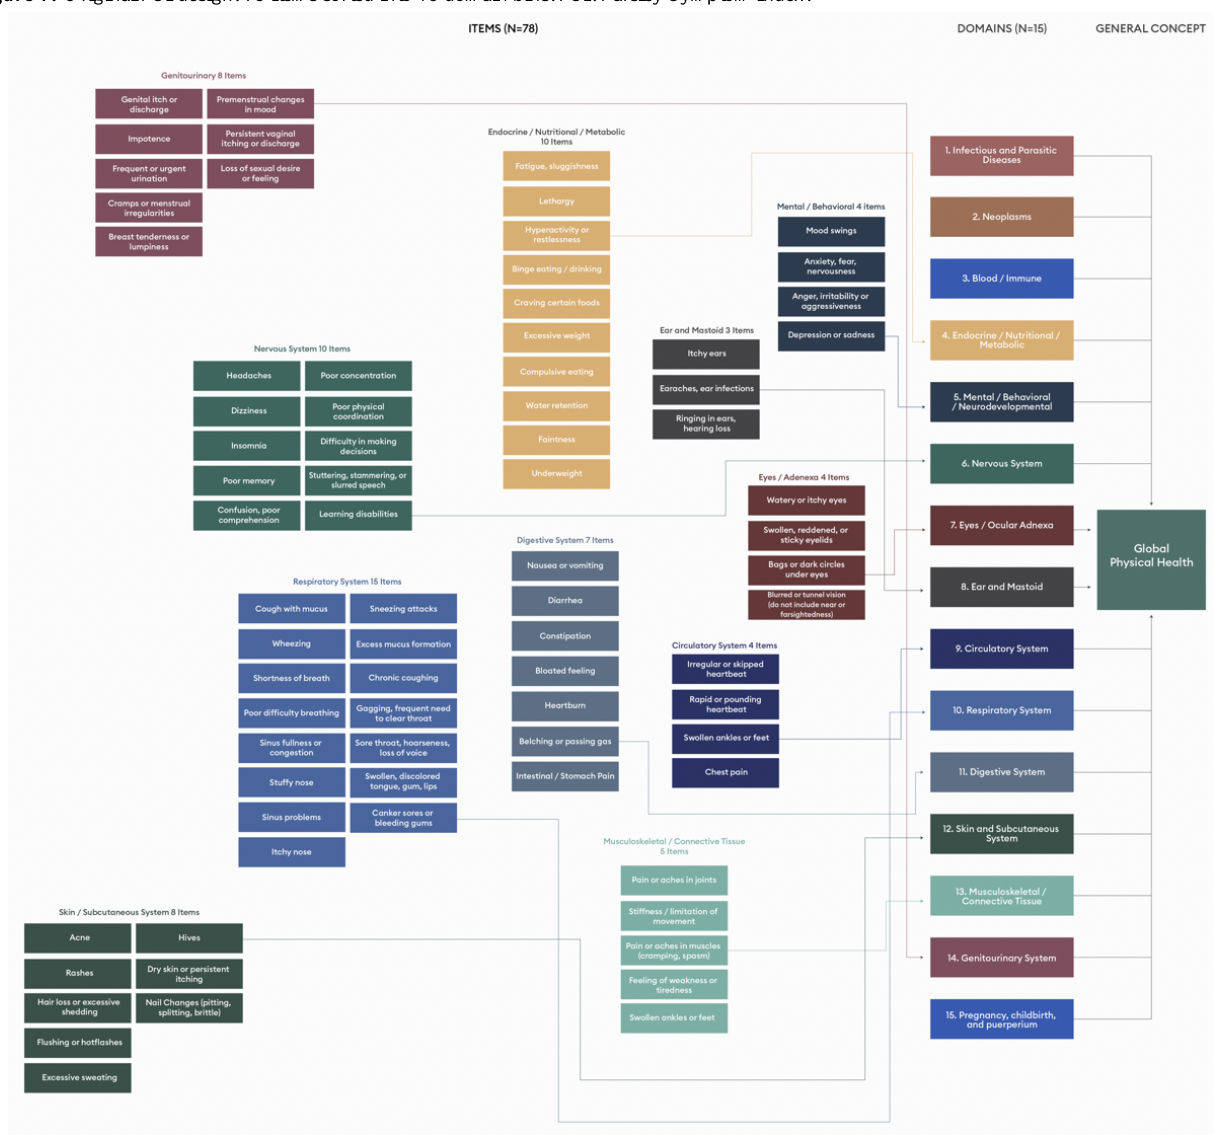
Figure 1. Original PSI design: 78 items sorted into 15 domain bins. PSI: Parsley Symptom Index.